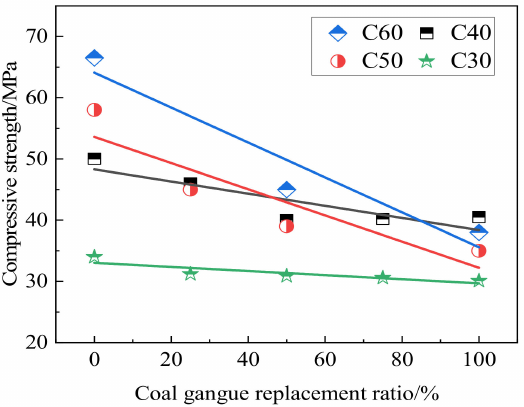
Figure 12. Influence of different gangue content on compressive strength of gangue concrete with different strength grades